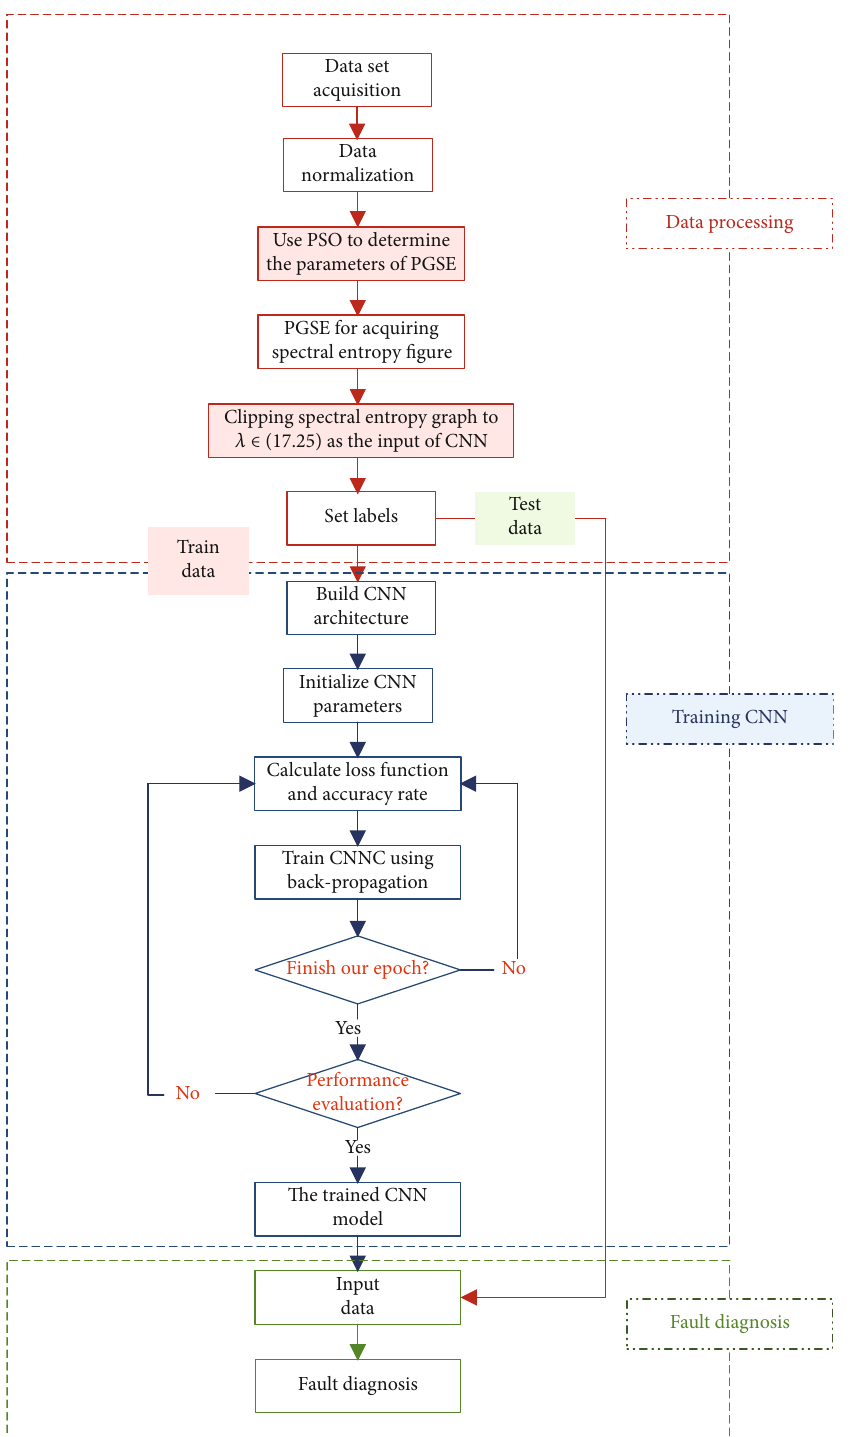
Figure 1: Flowchart of proposed